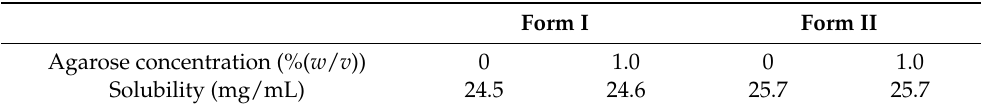
Table 1. Solubilities # of acetaminophen form I and form II in the presence (1.0% ( w / v )) and absence of agarose at 40 ◦